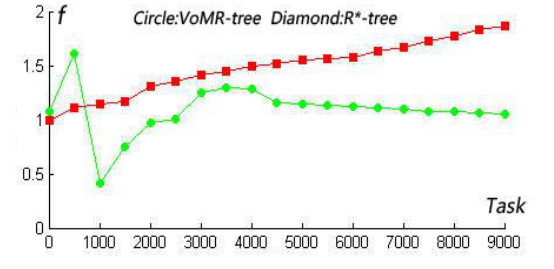
Figure 14. Task of